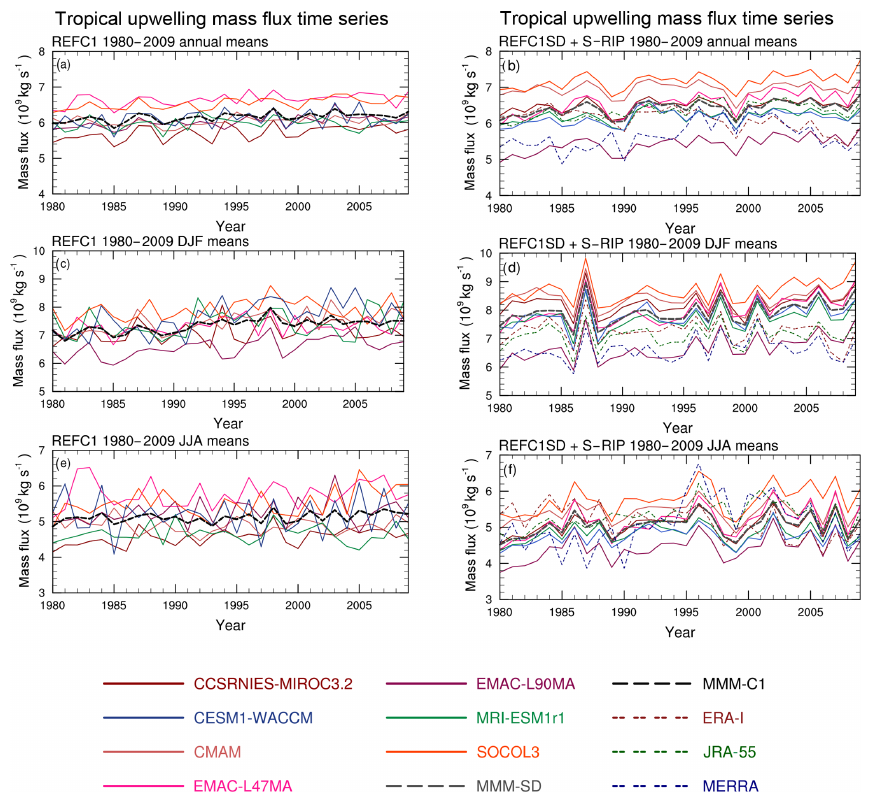
Figure 8. Top to bottom: time series of annual, DJF, and JJA means of tropical upward mass flux ( × 10 9 kgs − 1 ) at 70hPa for (a, c, e) REF-C1 and (b, d, f)